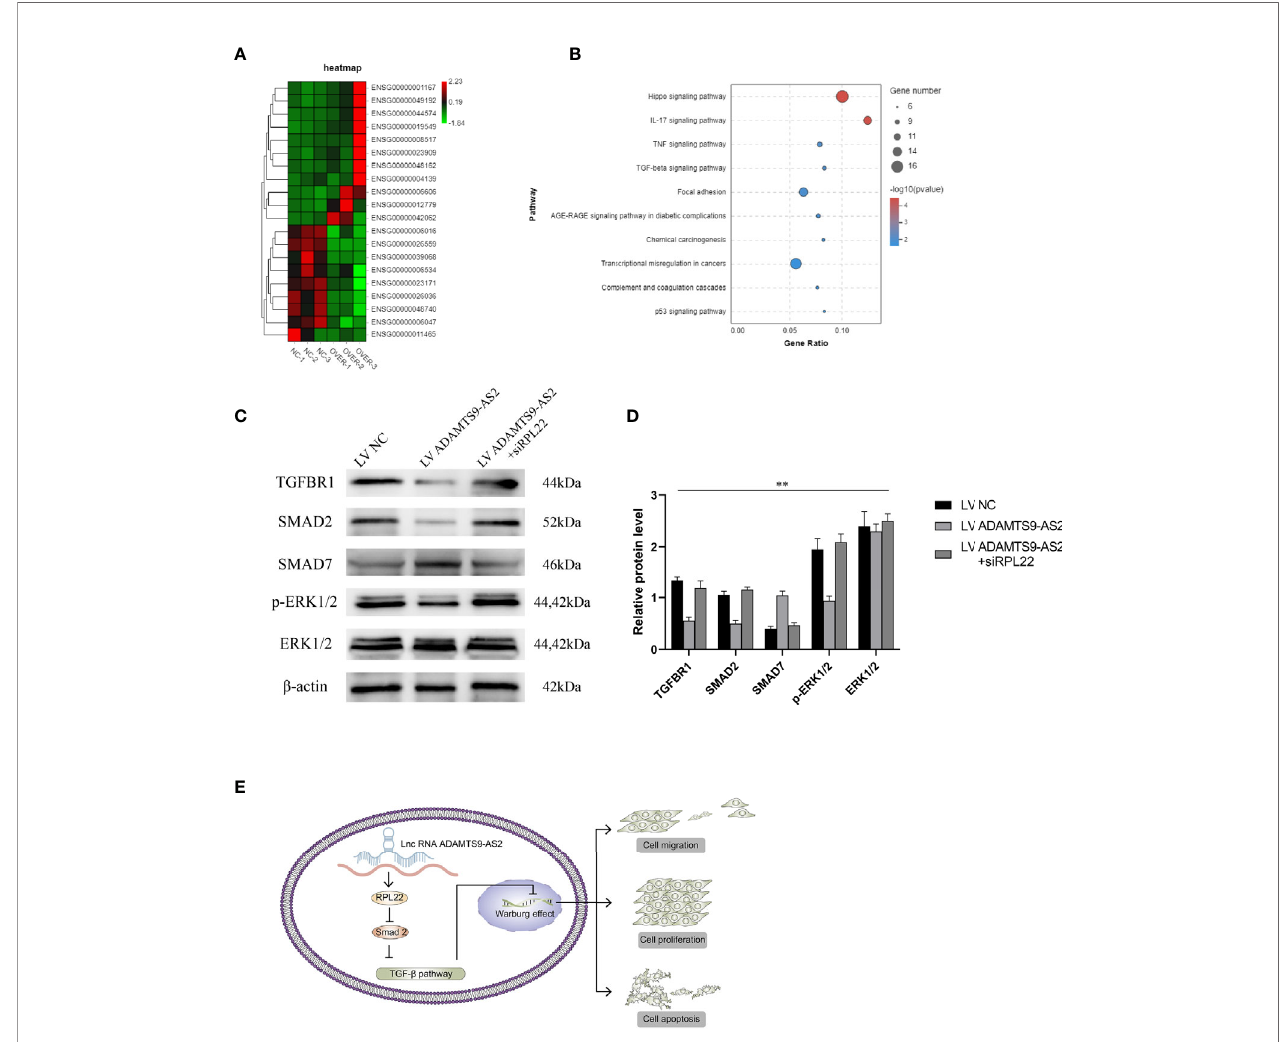
FIGURE 7 | ADAMTS9-AS2 regulates the TGF- b signaling pathway to control TNBC progression. (A) The cluster heat maps displayed the 20 most representative differentially expressed mRNAs with transcriptomic sequencing. (B) KEGG pathway analysis of differentially expressed mRNAs. (C, D) Western blot assay determined the total and active protein level of TGF- b signaling pathway related proteins in MDA-MB231 cell lines. (E) Summary of the mechanism of ADAMTS9-AS2 in TNBC cell lines. **P <